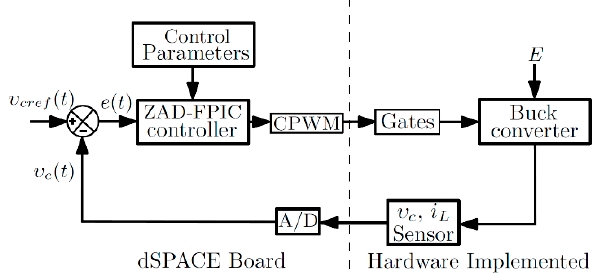
Figure 5. Block diagram of the implementation and control of the system with ZAD-FPIC.